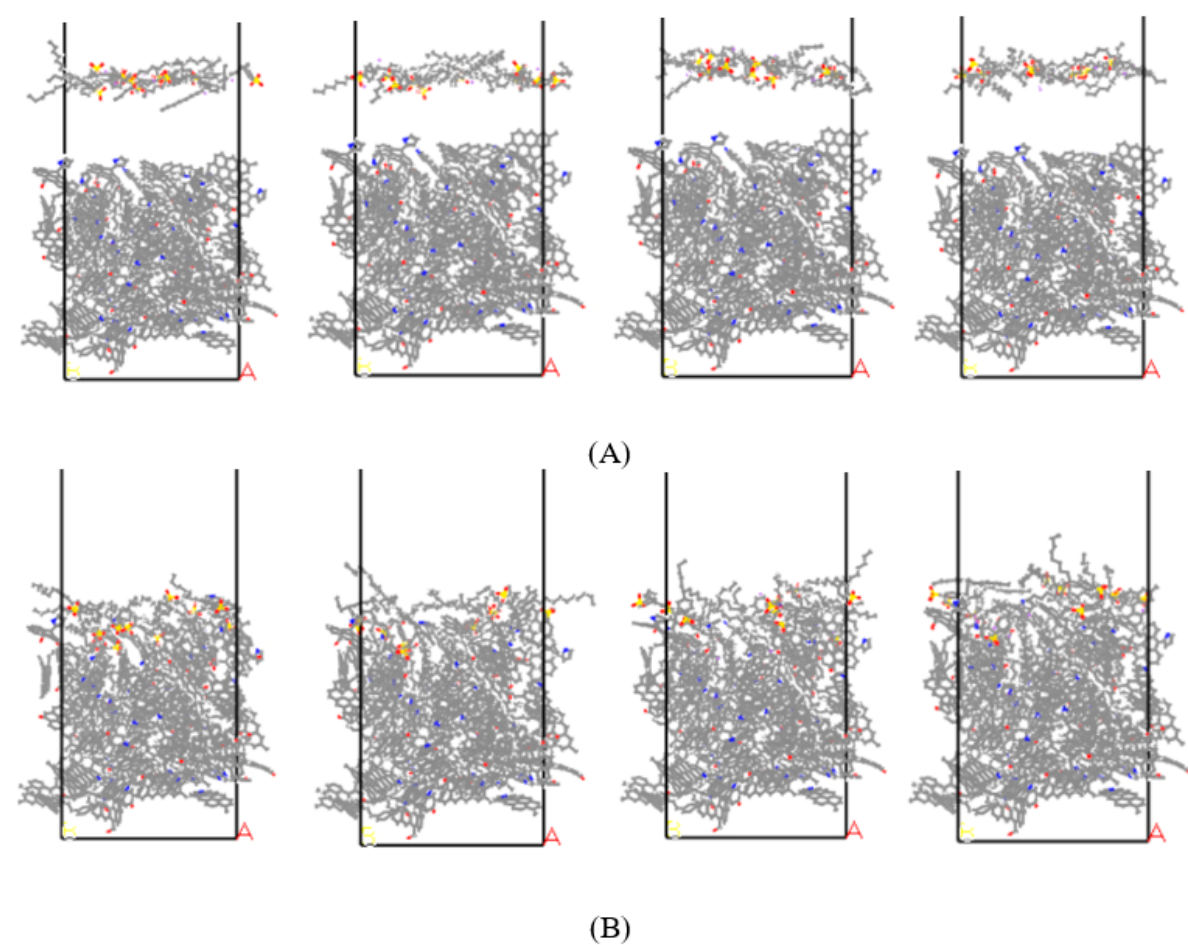
Figure 4. From left to right is the m ‐ C16/anthracite system (m = 2,4,6,8). ( A ) Initial configuration; ( B ) final configuration.